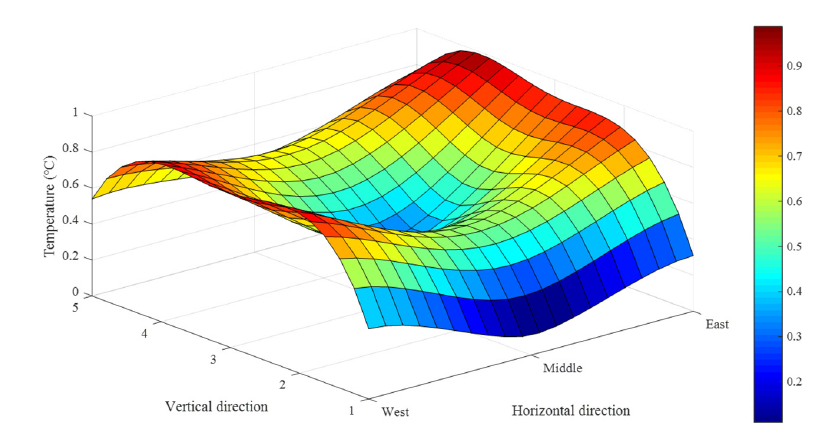
Figure 11. Average near-wall temperature difference distribution of B3 in summer.